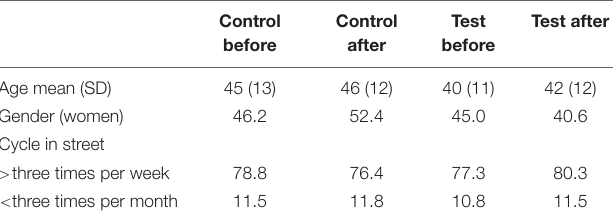
TABLE 3 | Background characteristics for respondents before and after in control and test streets per cent.